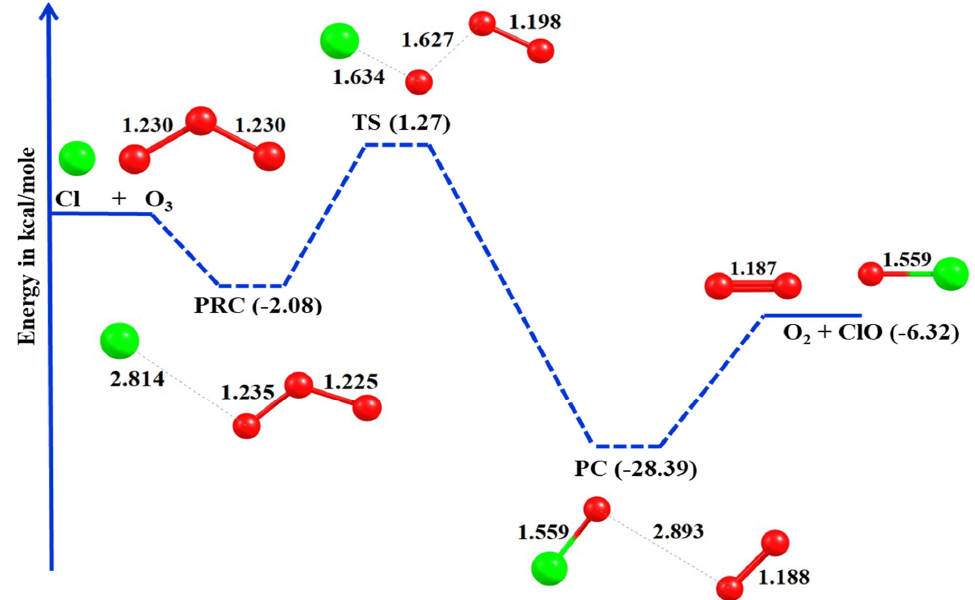
Figure 1. Potential energy level diagram for the reaction of O 3 with Cl obtained at the MRCI + Q/aug-ano-pVTZ//MP2/ aug-cc-pV(T + d)Z levels of